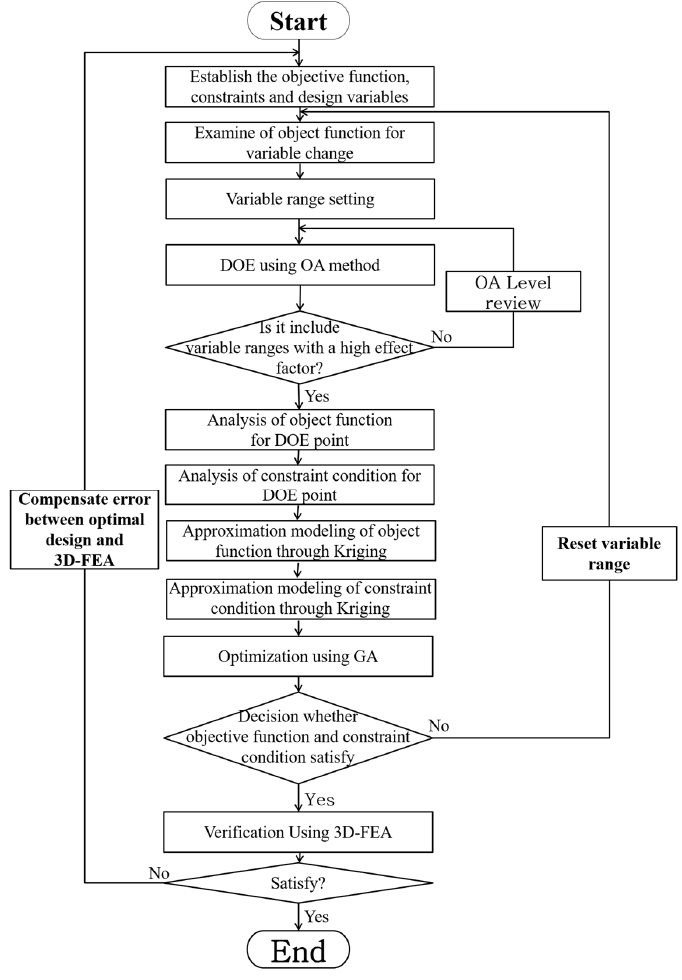
Figure 4. Flow chart of optimal design.